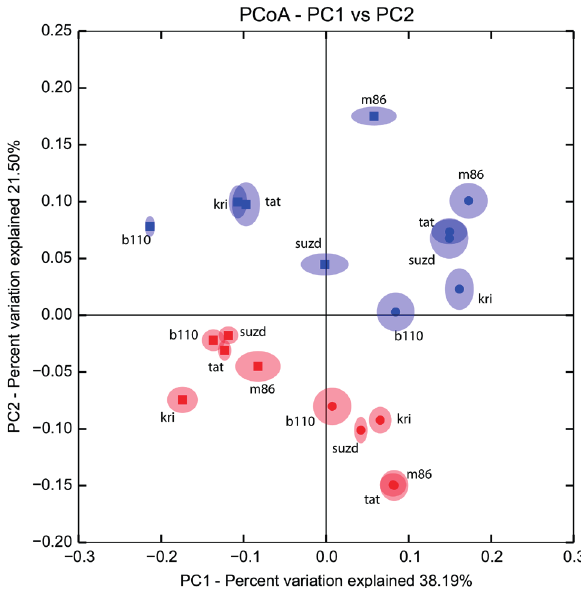
Figure 5 DNA metabarcoding data based on jackknifed beta- diversity PCoA plots with an unweighted Unifrac distance metric for barley samples categorized by year (blue for 2014; red for 2015) and surface treatment (dots – non-sterilized, squares – sterilized) Kri – Krinichnyy, Suz – Suzdalets, B110 – Belgorodskiy 110, Tat – Tatum, and M86 – Moskovskiy